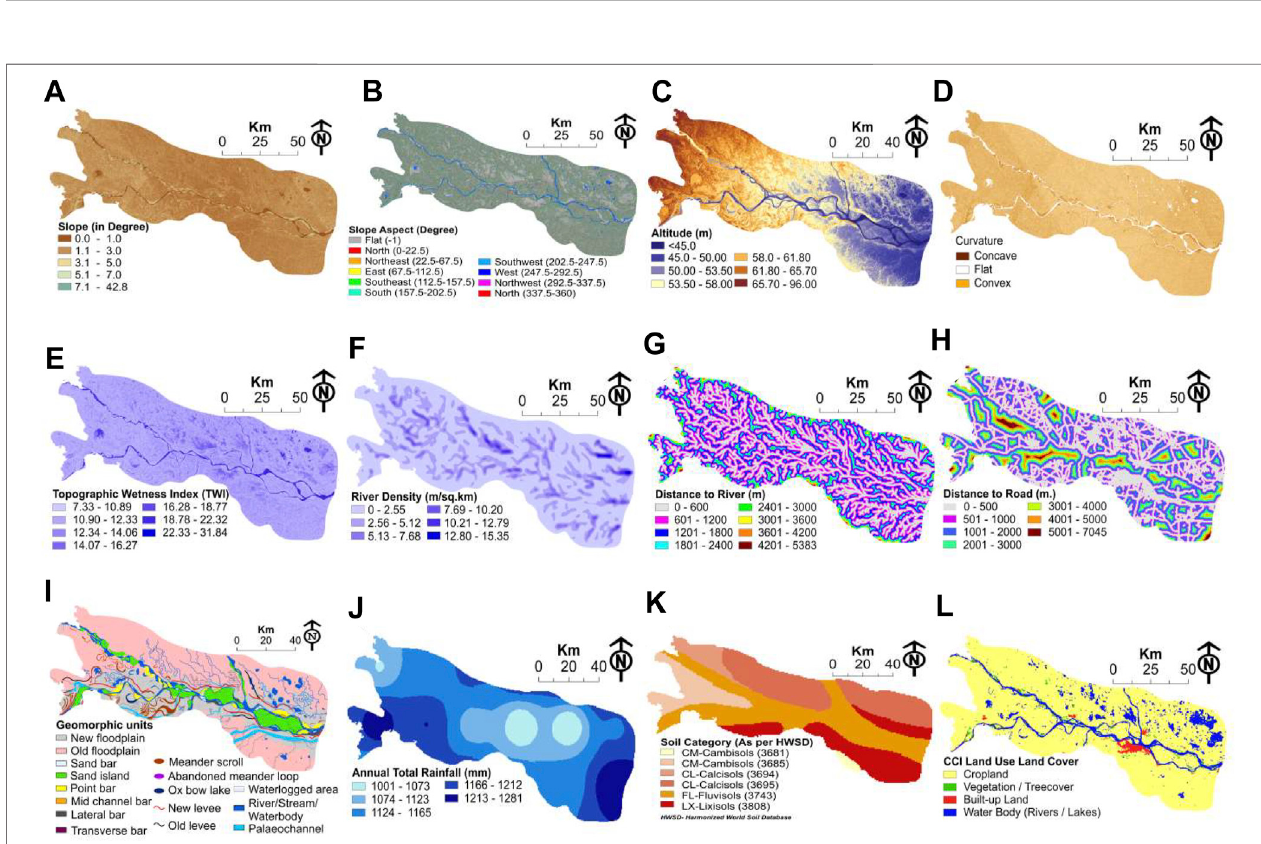
FIGURE3| Floodconditioningfactorsusedformodelingof fl oodsusceptibility.From (A – L) themapsindicateAltitude,Slope;Aspect;TWI;RiverDensity;Distance to Road; Annual Rainfall (mm); Soils; Curvature, Distance to River; LULC; and Geomorphology.